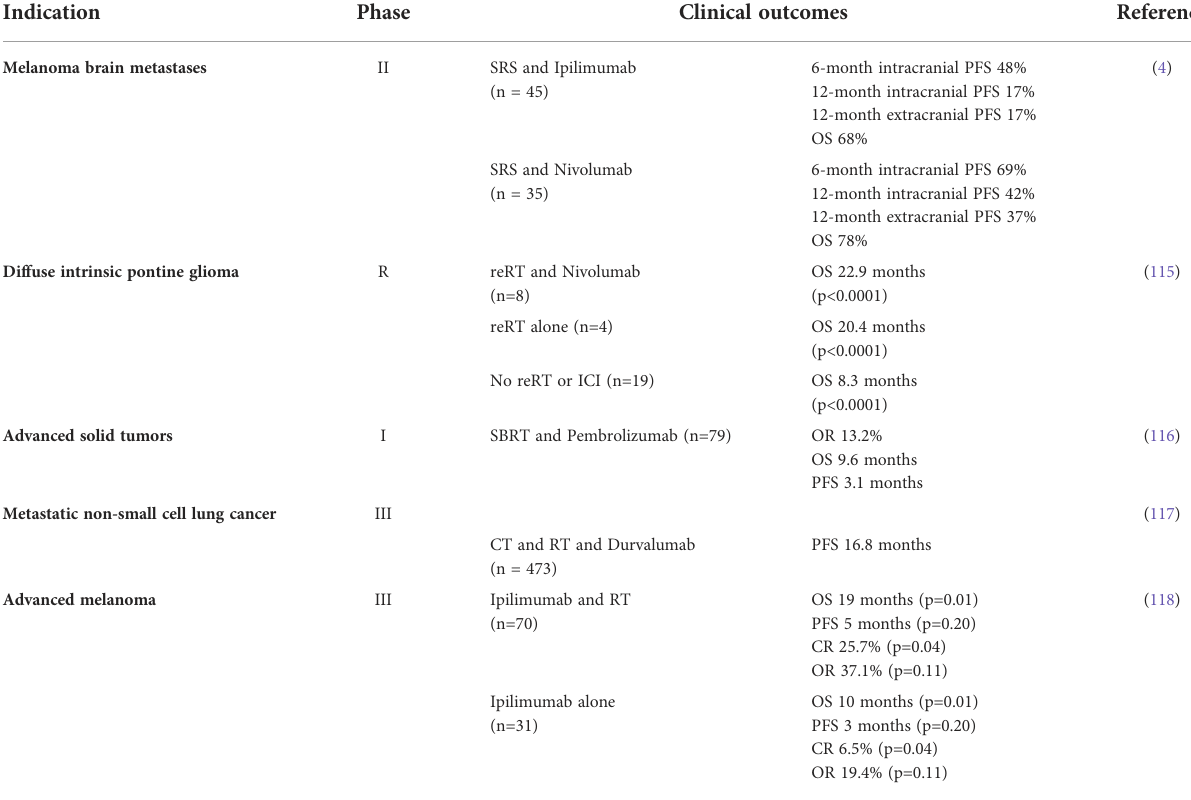
TABLE 2 Examples of clinical trials evaluating ef fi cacy of RT+ICI